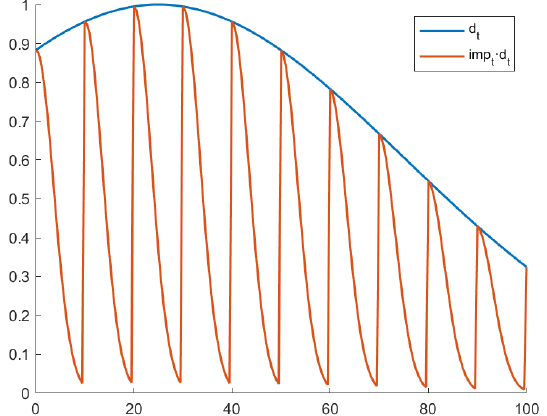
Figure 4. Plot of 𝑑 (cid:3047) and 𝑖𝑚𝑝 (cid:3047) ∙ 𝑑 (cid:3047)